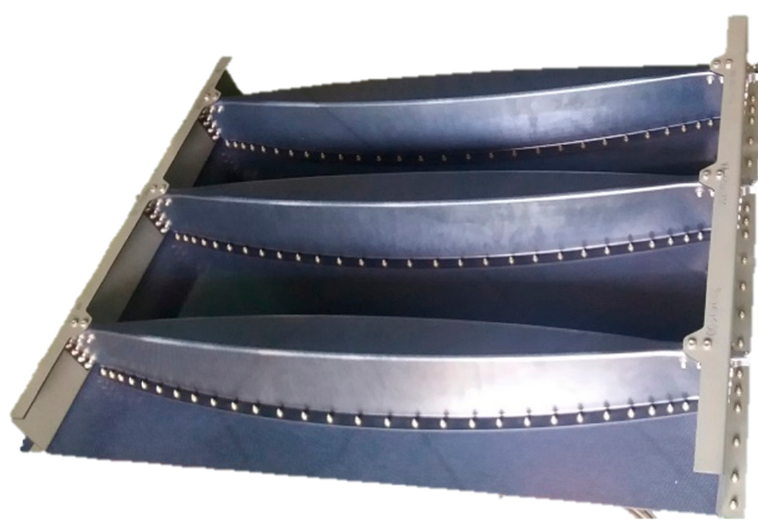
Figure 1. Door panel with Omega beams and Z